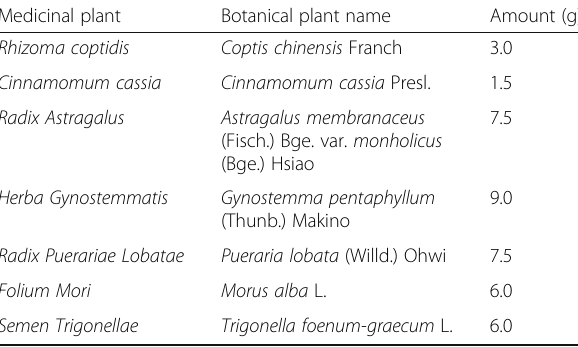
Table 1 Composition of Jia-Wei-Jiao-Tai-Wan